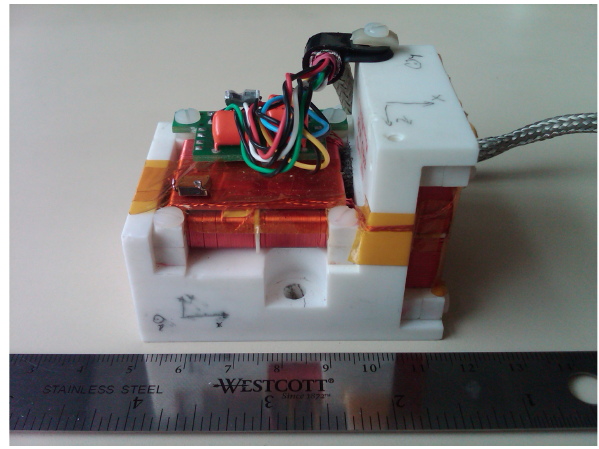
Fig. 1. Fluxgate sensor used in the prototype instrument. This hard- ware is the CASSIOPE/ePOP MGF engineering model with minor